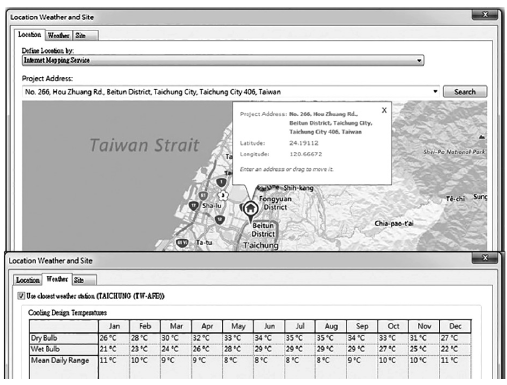
Figure 9. Site location settings TMY weather data